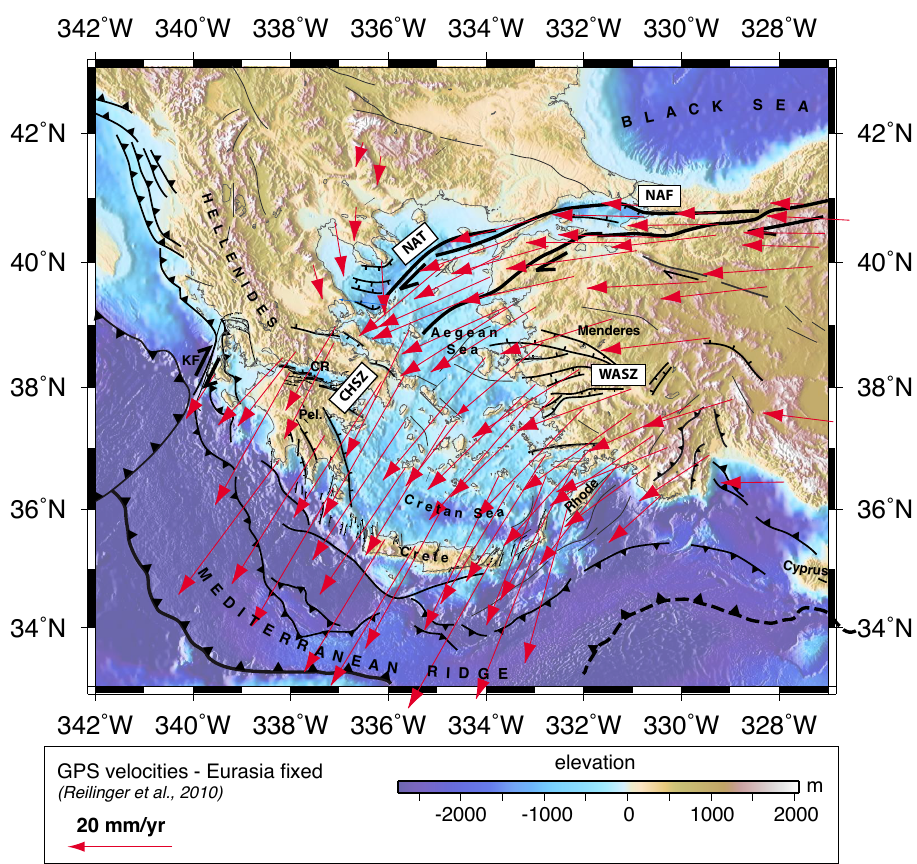
Fig. 1. Tectonic map of the Aegean and Anatolian regions showing the main active structures (after Jolivet et al., 2013) and GPS velocity field (Eurasia fixed, after Reilinger et al., 2010). Topographic data come from the ETOPO1 global relief model (Amante and Eakins, 2009). CHSZ: Central Hellenic Shear Zone; CR: Corinth Rift; KF: Kefalonia Fault; NAF: North Anatolian Fault; NAT: North Aegean Trough; Pel: Peloponnese; WASZ: Western Anatolian Shear